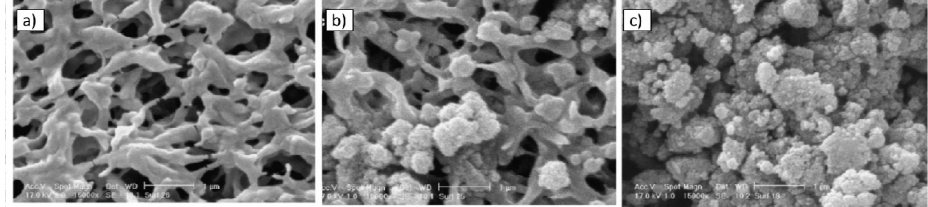
Figure 4. SEM images: ( a ) bare PVDF membrane; ( b ) PAA and self-assembling of TiO 2 ; and ( c ) grafted by mixture of PAA and TiO 2 . Taken from